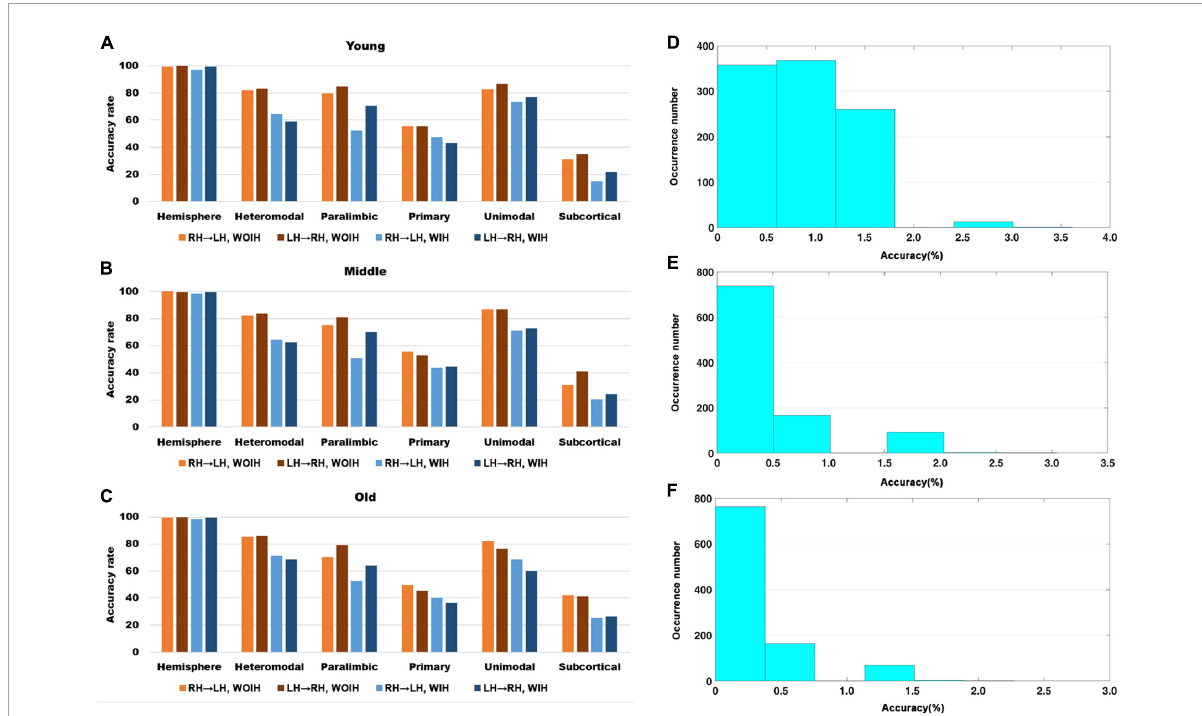
FIGURE3 The recognition rate results of hemisphere and each sub-module in different age groups. (A–C) Represents the recognition rate of young, middle and old, respectively. From left to right in each sub graph, the recognition rate of hemisphere and five sub-modules are in turn. Notably, Orange indicates that the RH recognizes the LH without Ipsilateral Hemisphere (RH → LH, WOIH). Brown indicates that the LH recognizes the RH without ipsilateral hemisphere (LH → RH, WOIH). Light blue indicates that the RH recognizes the LH with ipsilateral hemisphere (RH → LH, WIH). Dark blue indicates that the LH recognizes the RH with ipsilateral hemisphere (LH → RH, WIH). (D–F) Correspond to non-parametric permutation test of (A–C) ,